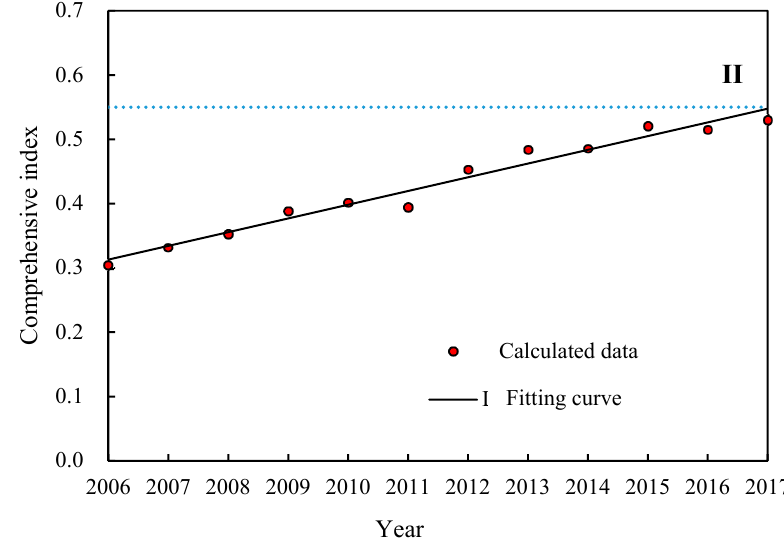
Figure 2. Comprehensive index of WECC in 2006–2017.